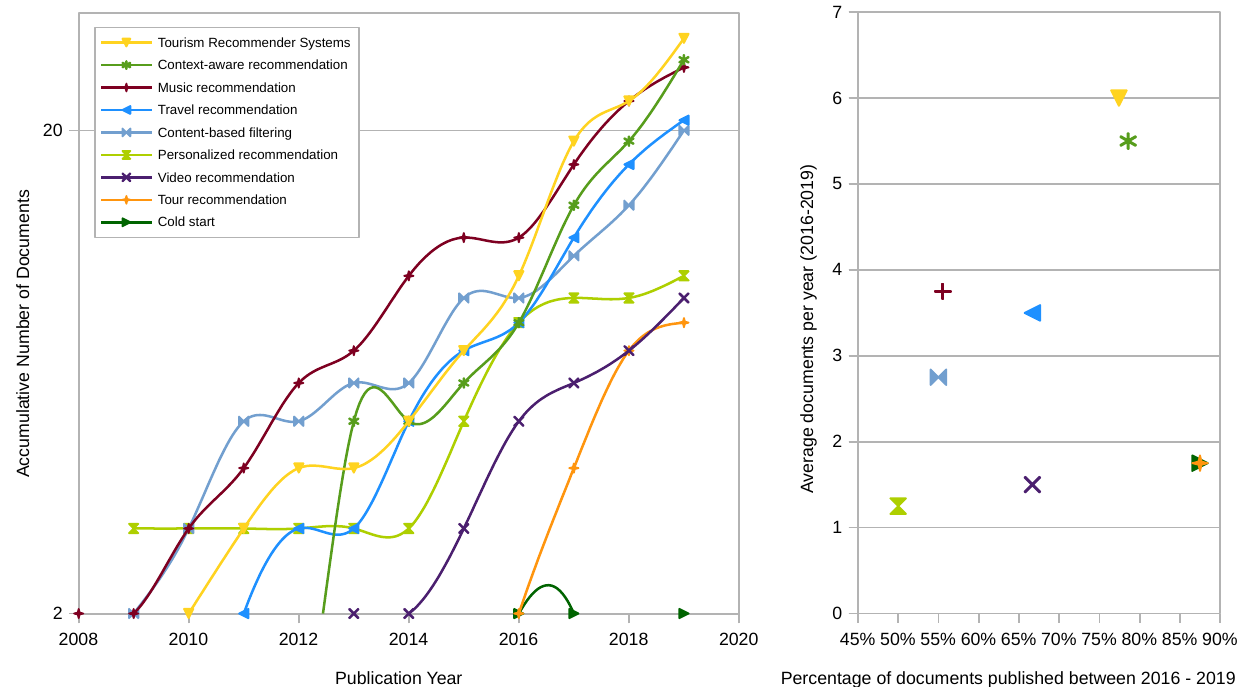
Figure 4. Trends of approaches, frameworks, and applications in recommendation systems